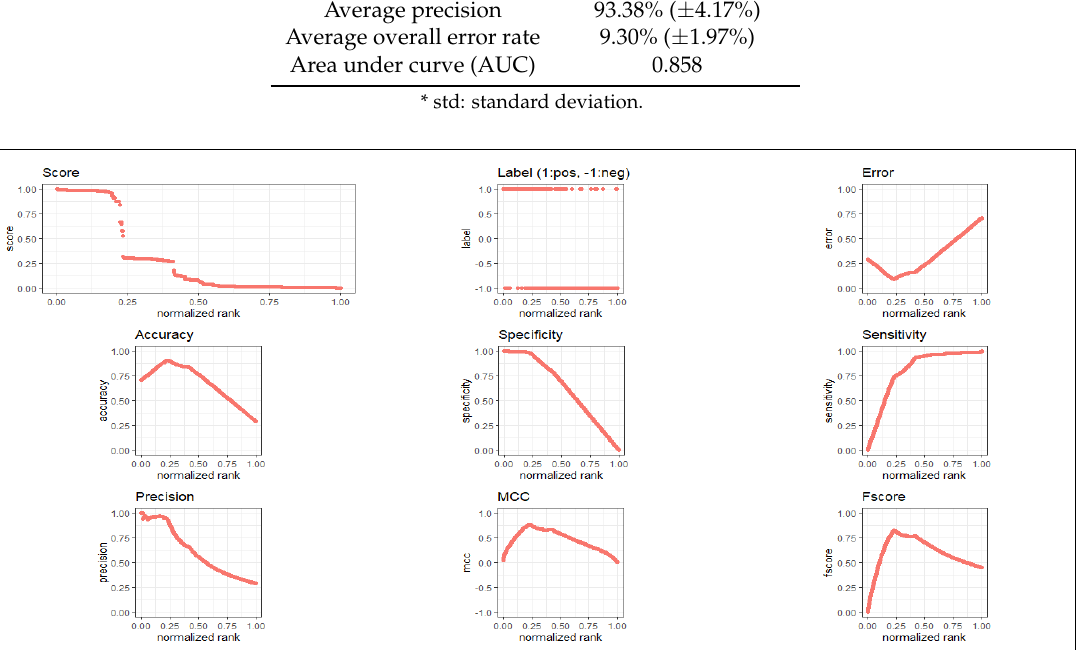
Figure 2. ROC plots of all classification metrics for the proposed